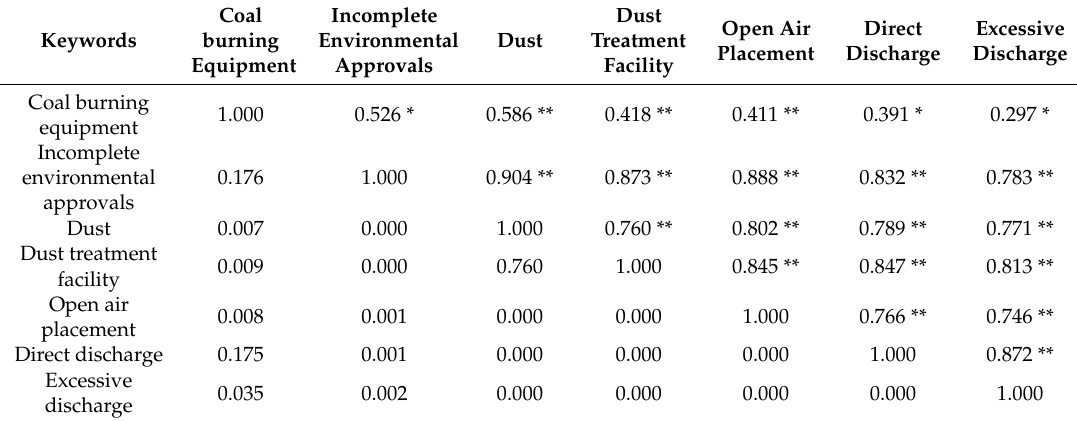
Table 2. Part of the correlation matrix.